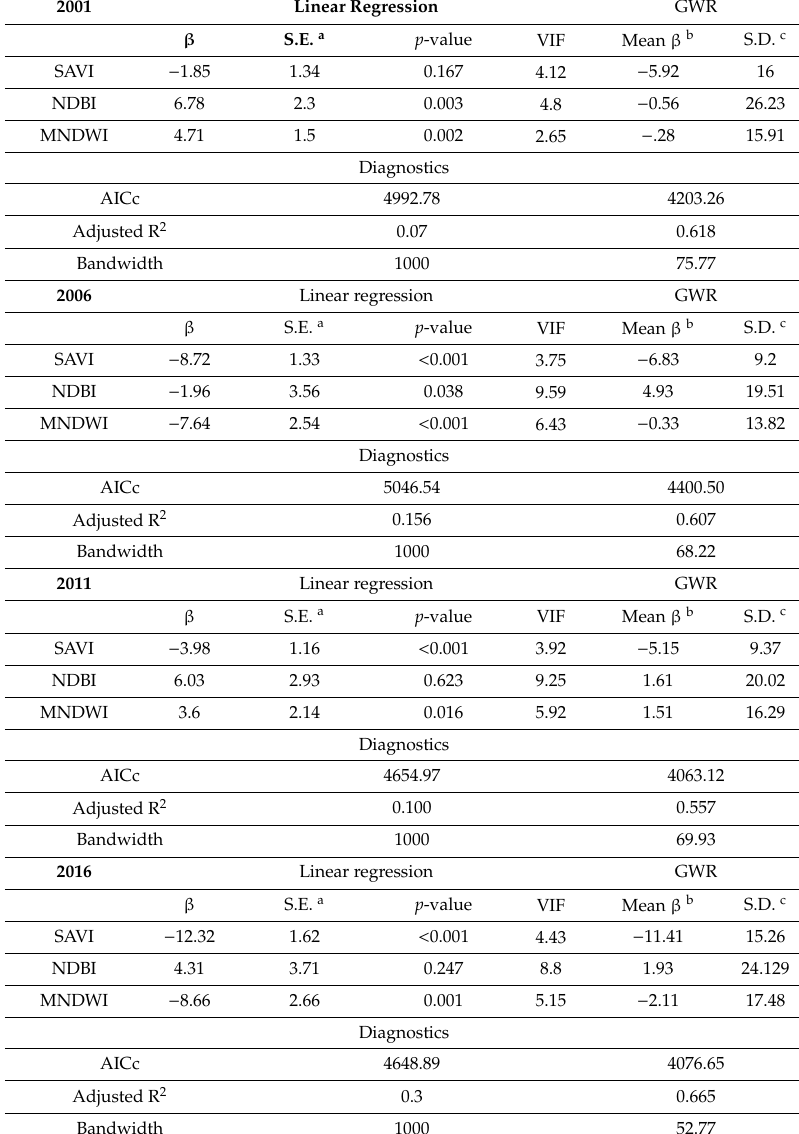
Table 3. Summary of parameter estimates and diagnostics for the linear regression and geographically weighted regression (GWR) for 2001, 2006, 2011, and